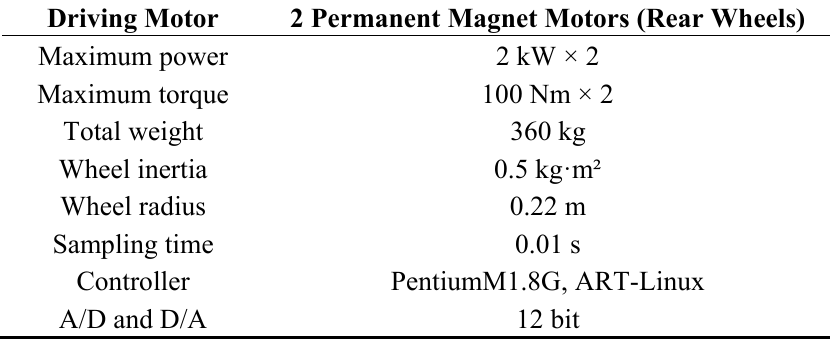
Table 1. Specifications of an experimental electric vehicle.